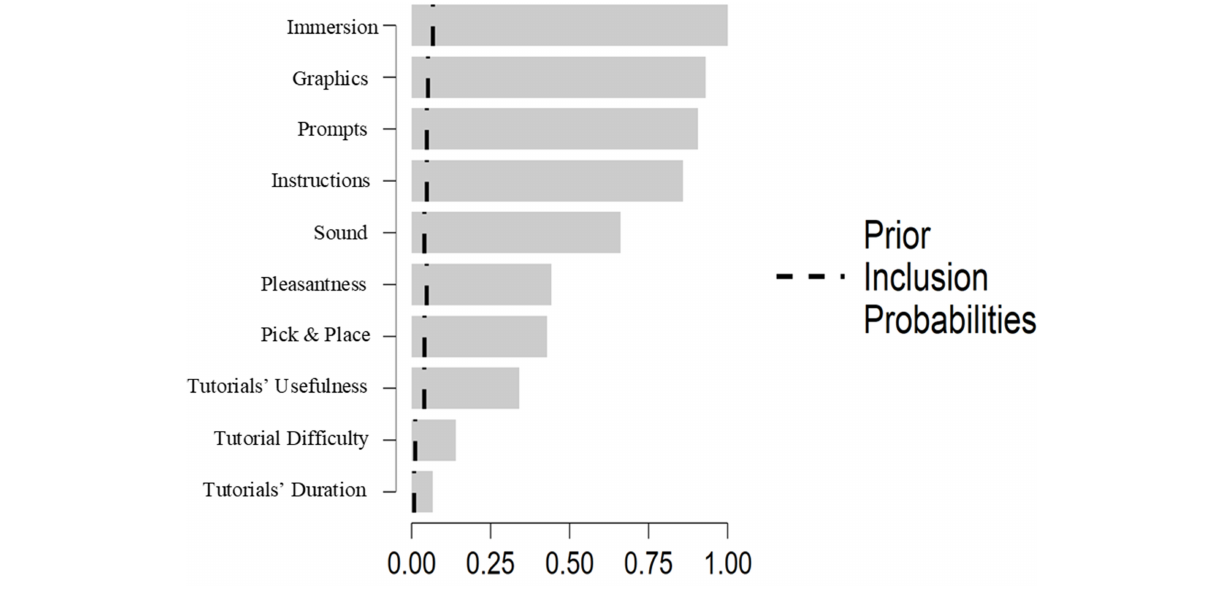
FIGURE 3 | Variables’ prior inclusion